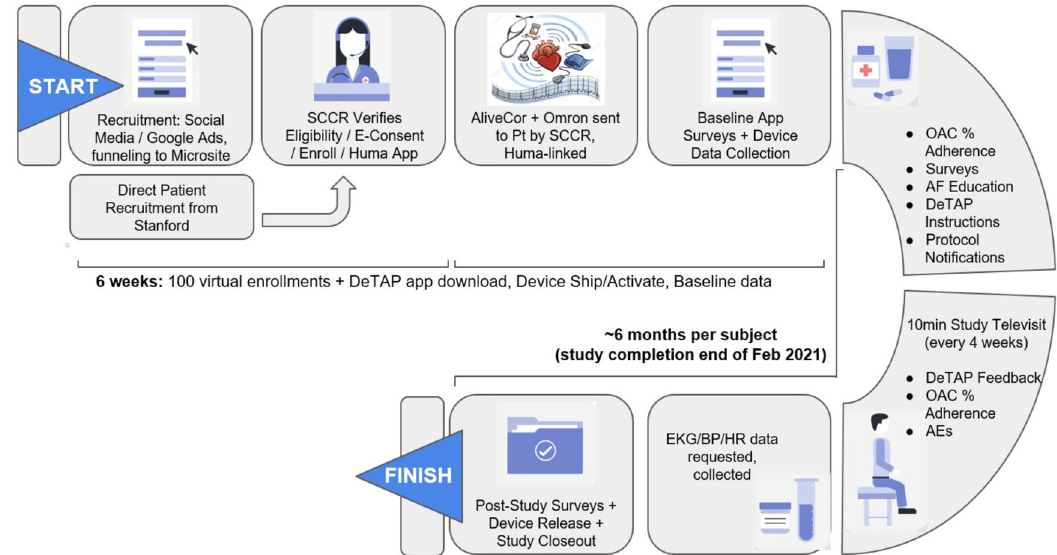
Fig. 3 DeTAP study protocol fl ow. SCCR Stanford Center for Clinical Research, OAC oral anticoagulant, EKG electrocardiogram, BP blood pressure, HR heart rate, DeTAP decentralized trial in a fi b patients, App smartphone/mobile application, AF atrial fi brillation, AEs adverse